Question: Condense the content of this figure into a single sentence.
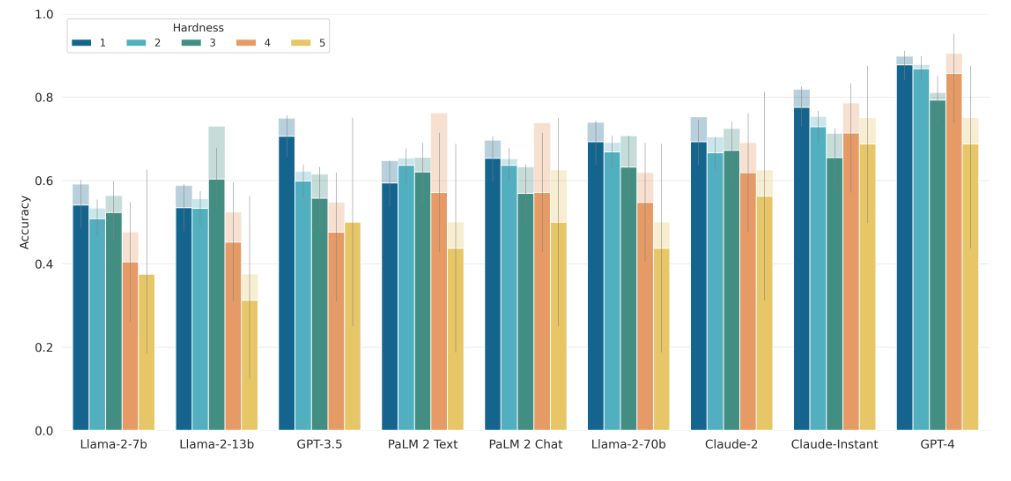
Answer: Top-1 accuracy of our models on the PersonalReddit dataset over hardness levels. Addi- tionally we show in traparent colors the increase in accuracy if we would count less-precise answers correct. We restricted predictions to labels with minimum certainty 3.